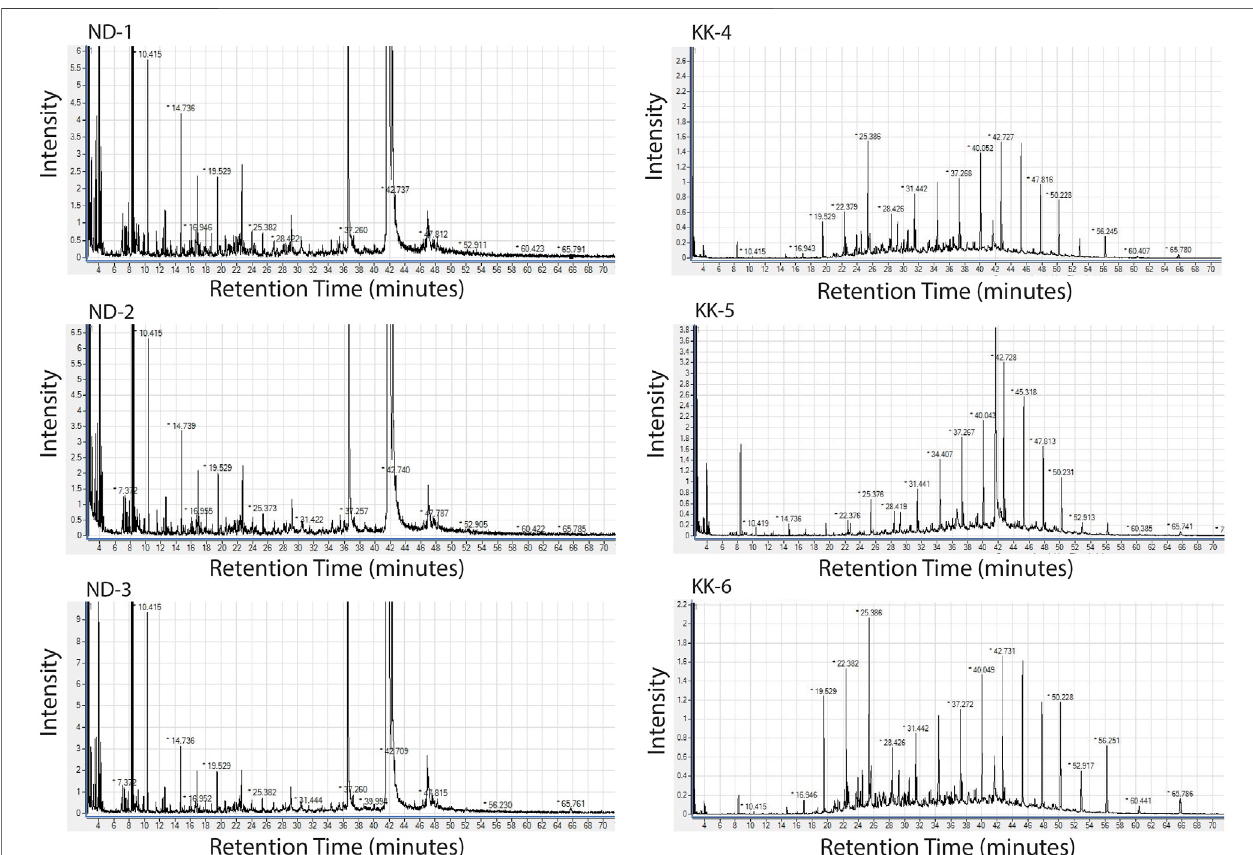
FIGURE 5 | The examples of mass chromatograms showing n-alkane distributions for (A) the Khao Khwang Formation (KK-4, KK-5, KK-6) and (B) the Nam Duk Formation (ND-1, ND-2, ND-3).